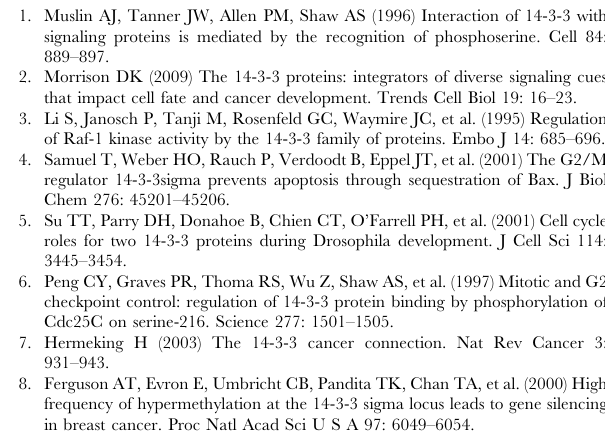
Figure S1 Transformation assay in MEF cells. H-ras and 14-3-3 expression plasmids were transfected into MEF cells as described